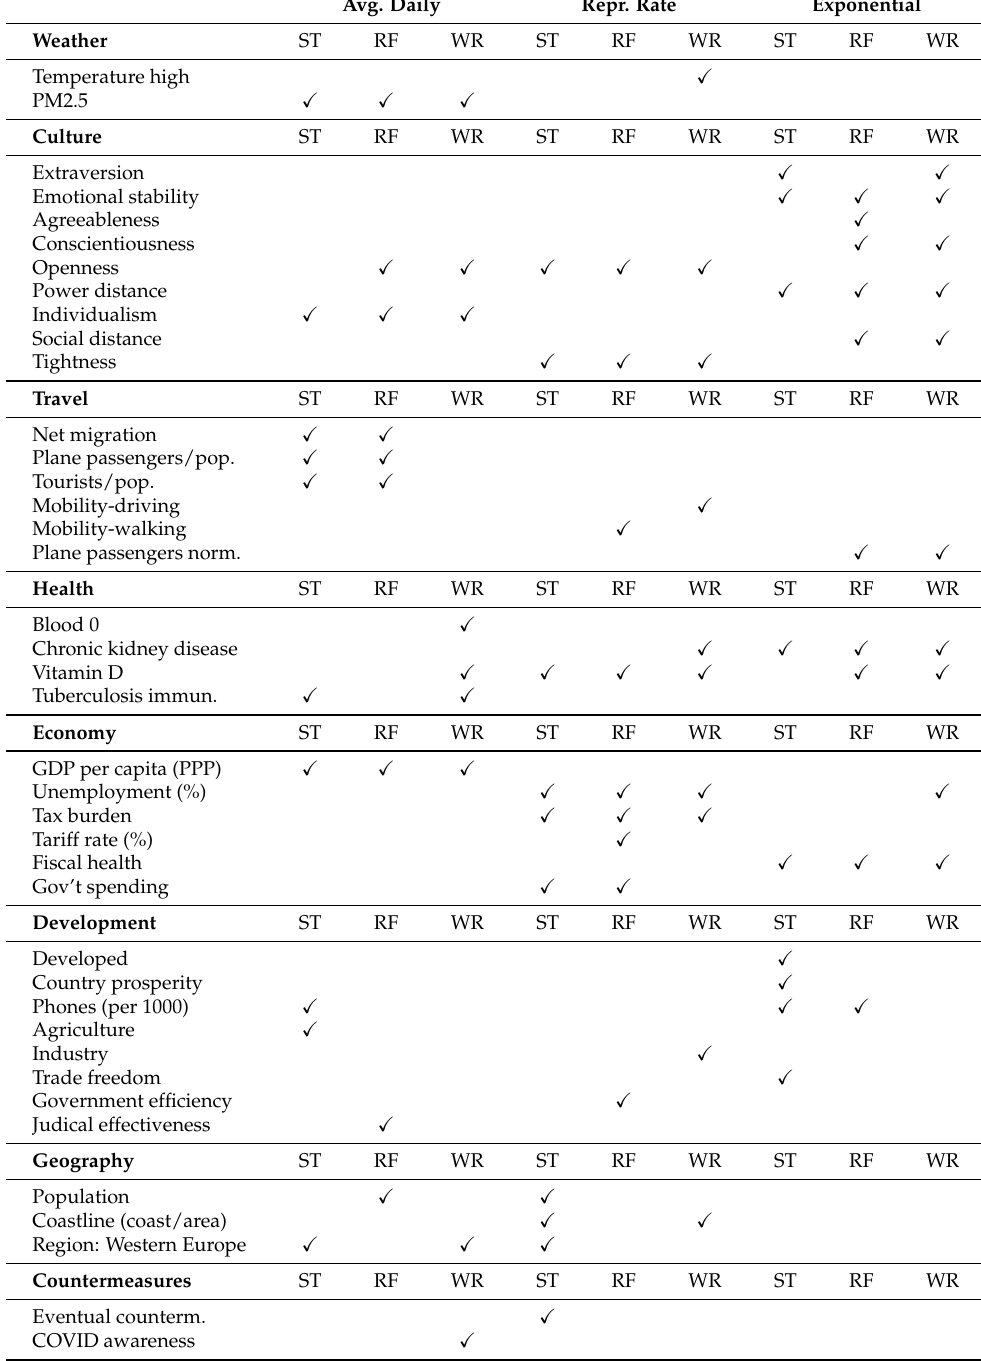
Table 7. Features that were in the top list for at least one class and feature ranking combinations. Such combinations are explicitly marked. Feature rankings are marked: ST—using statistical methods, RF—Using the Random Forest classifier, and WR—using the Wrapper FS procedure. Avg. Daily Repr.